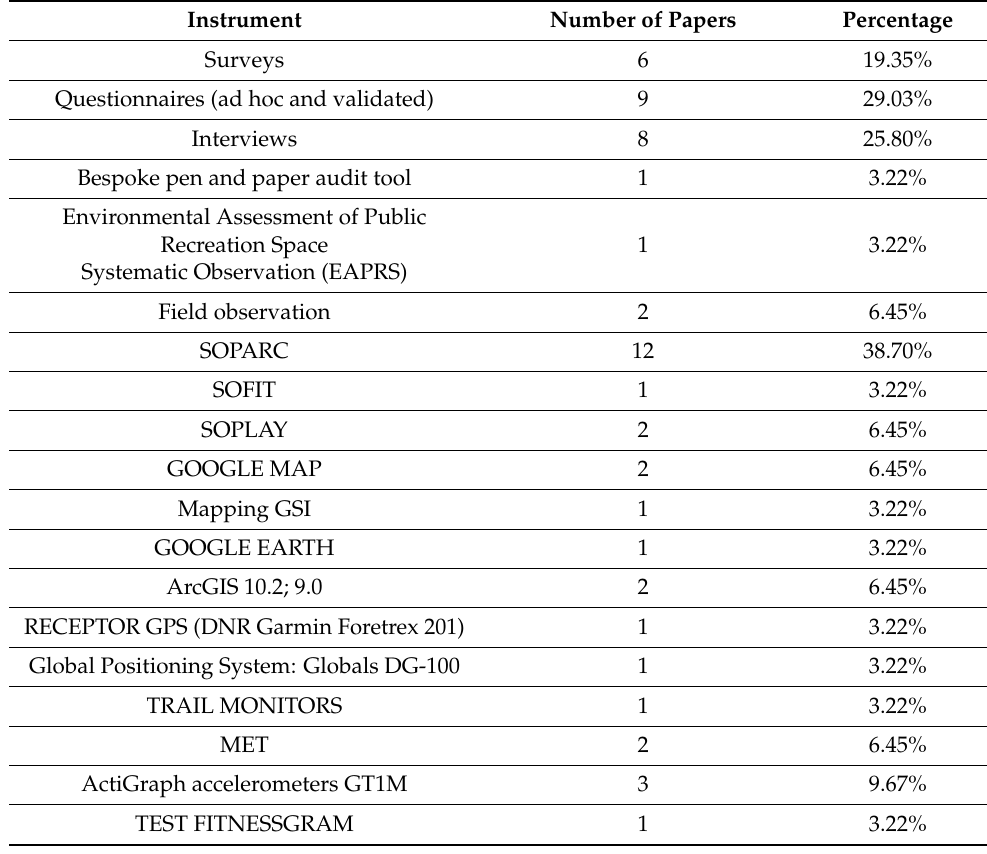
Table 6. Frequency of instrument